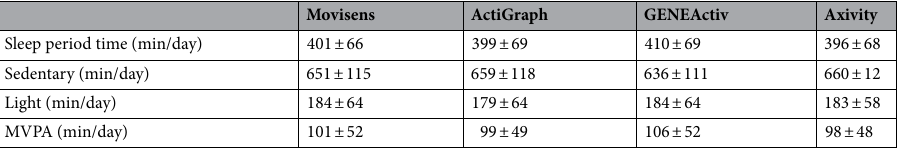
Table 2. Mean and SD for sedentary time, light PA, MVPA, and sleep, as determined with the different activity monitors (i.e., Movisens, ActiGraph, GENEActiv, and Axivity). PA physical activity, SD standard deviation.